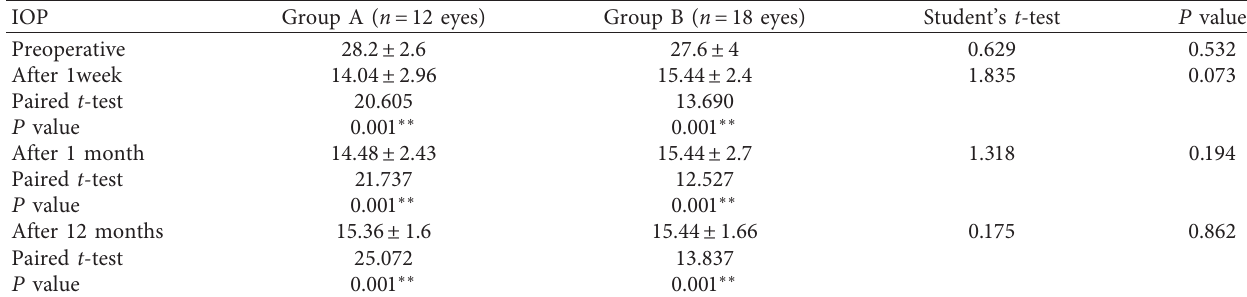
Table 2: Difference in IOP control between the two